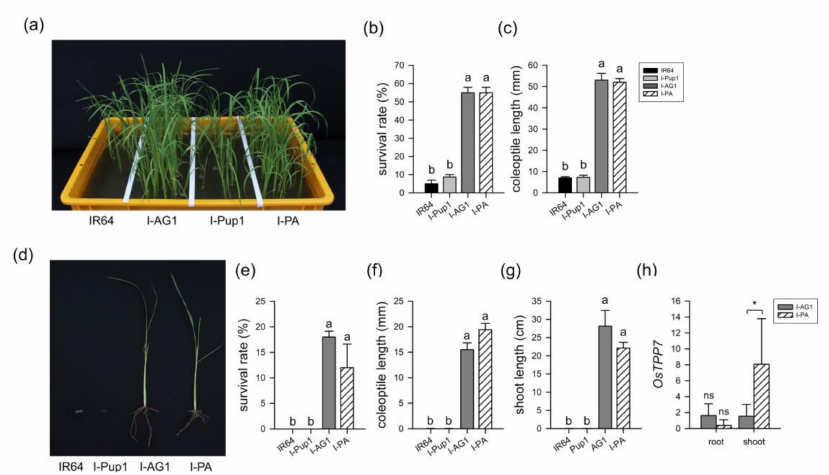
Figure 5. Germination rate, coleoptile elongation, and OsTPP7 expression levels of I-PA under anaerobic conditions. The tolerance phenotype of I-PA and I-AG1 to anaerobic germination conditions at 21 DAS. ( a – c ) and ( d – g ) are phenotypic results of hypoxia and anoxia conditions, respectively. ( h ) the transcriptional level of OsTPP7 in I-PA and I-AG1 under anoxia conditions (IR64 and I-Pup1 did not geminate). The letters above bars represent statistical significance ( p < 0.01) as measured by Duncan’s multiple range test. ns: no significant di ff erence. The asterisk represents statistically significant di ff erence ( p < 0.05) between I-AG1 and I-PA in (h).